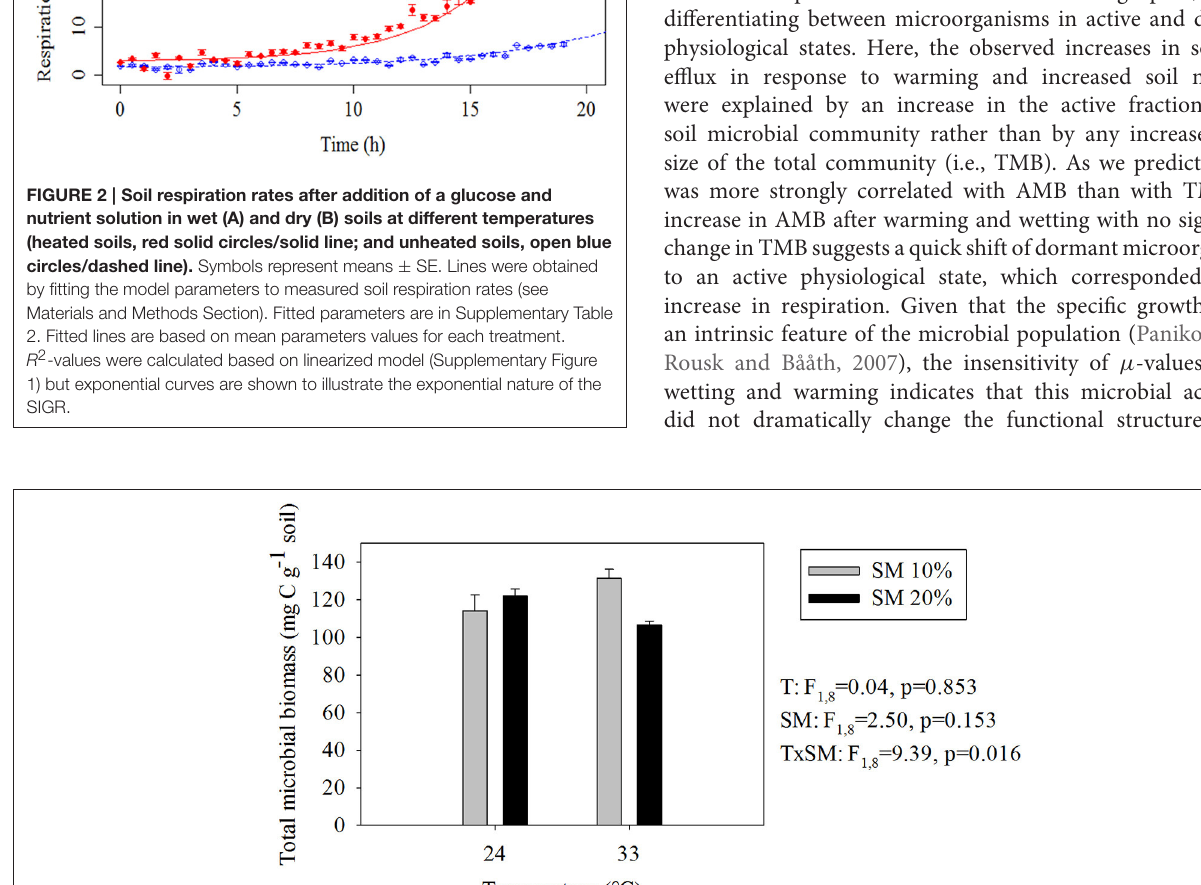
Frontiers in Microbiology |